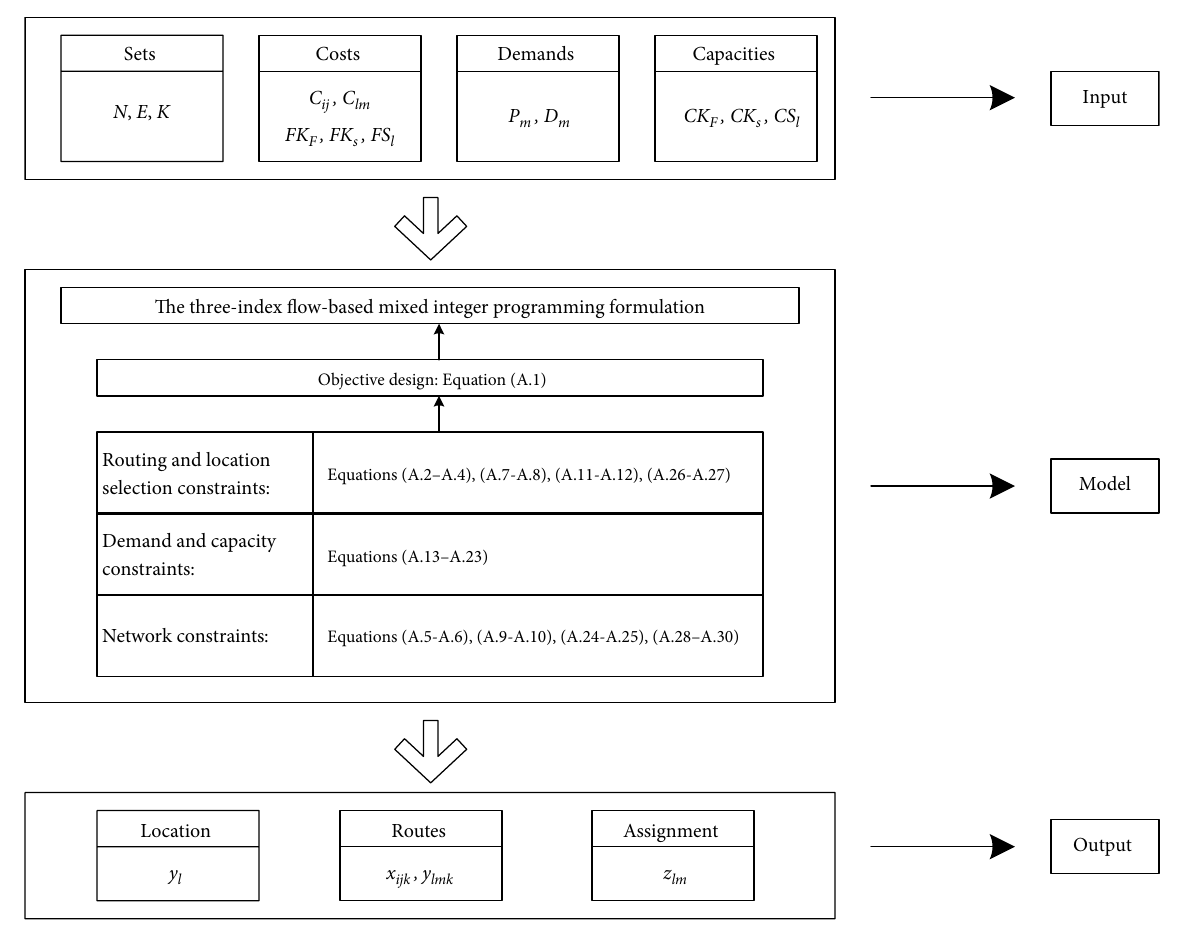
Figure 3: Flowchart with input, output, and